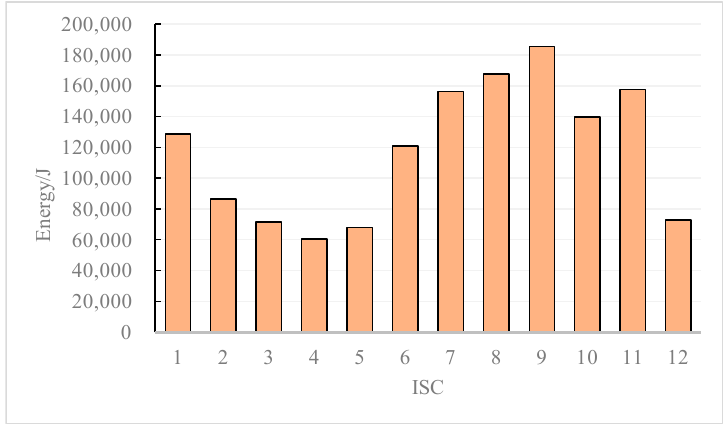
Figure 7. Energy value of each ISC component.